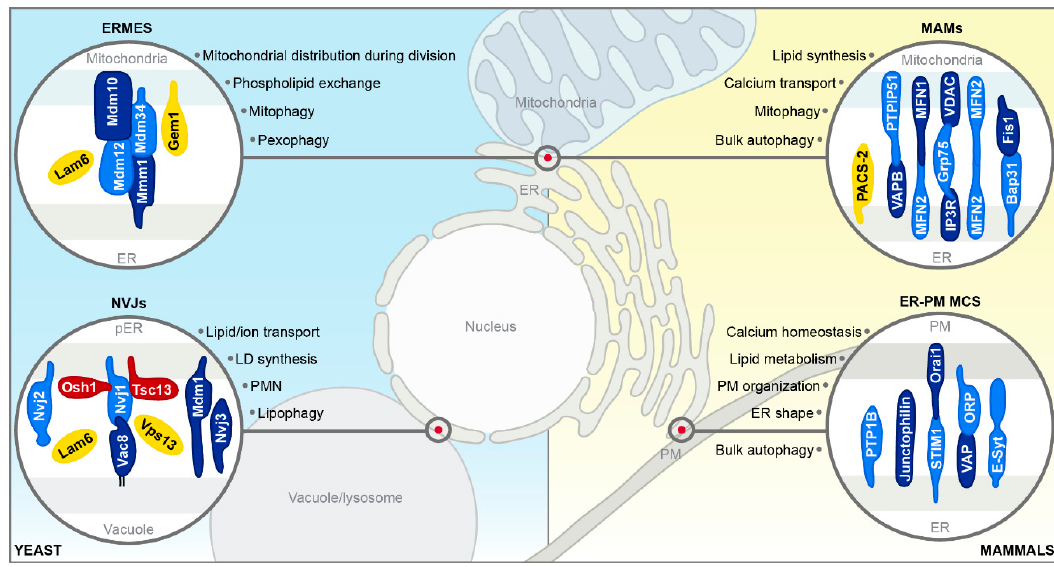
Figure 2. Schematic overview of selected membrane contact sites. Tether proteins (blue), proteins with other functions (red) and regulatory proteins (yellow) are depicted. For a general description of membrane contact sites (MCS) in yeast (blue) and mammals (yellow), please see main text. ER = endoplasmic reticulum; ERMES = ER–mitochondria encounter structure; pER = perinuclear ER; NVJs = nucleus–vacuole junctions; LD = lipid droplet; PMN = piecemeal microautophagy of the nucleus; MAMs = mitochondria-associated membranes; PM = plasma membrane.